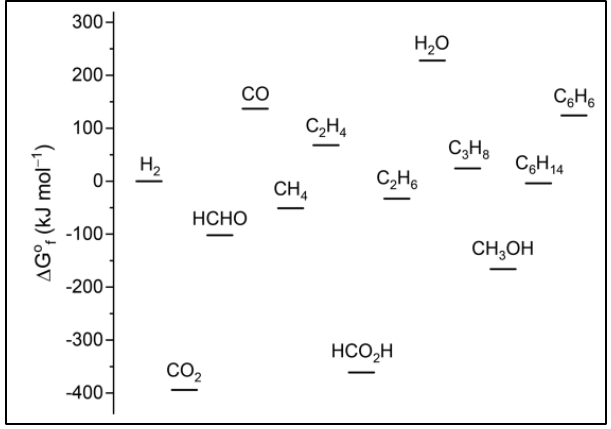
Figure 19. Values of standard Gibbs free formation energy for some carbon compounds at different C oxidation states. Reproduced with permission from Ref. [174]. Copyright© 2020, American Chemical Society.